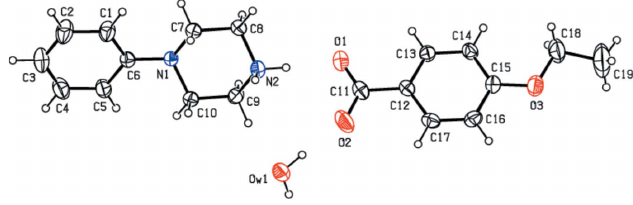
Figure 1 The independent components of compound ( I ) showing the atom- labelling scheme. Displacement ellipsoids are drawn at the 30% probability